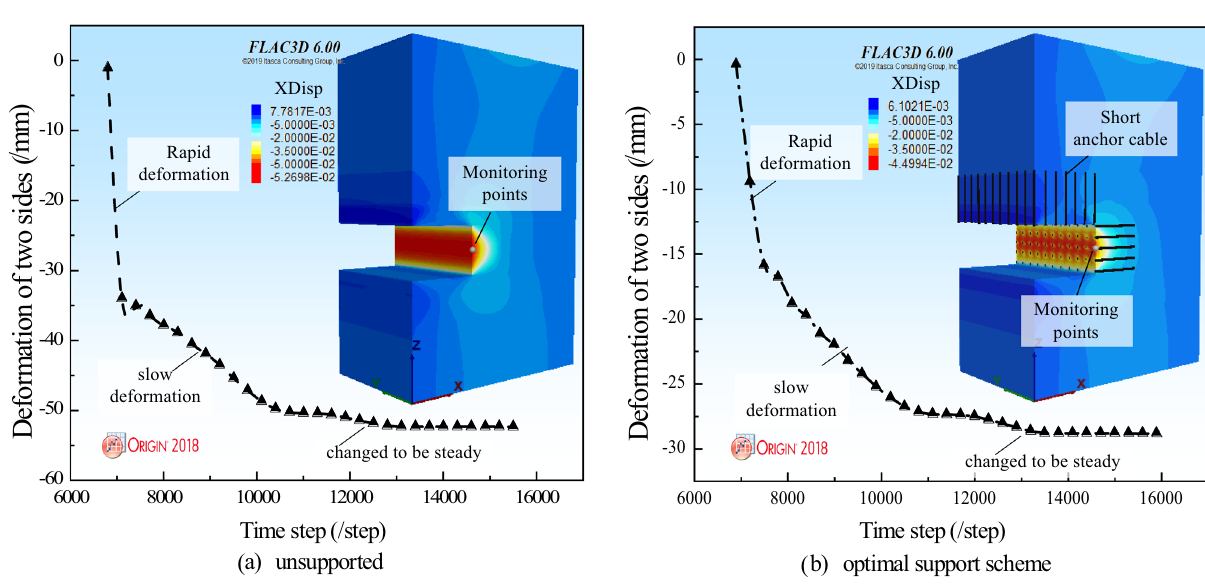
Figure 7. Comparison of displacement fields of two sides of surrounding